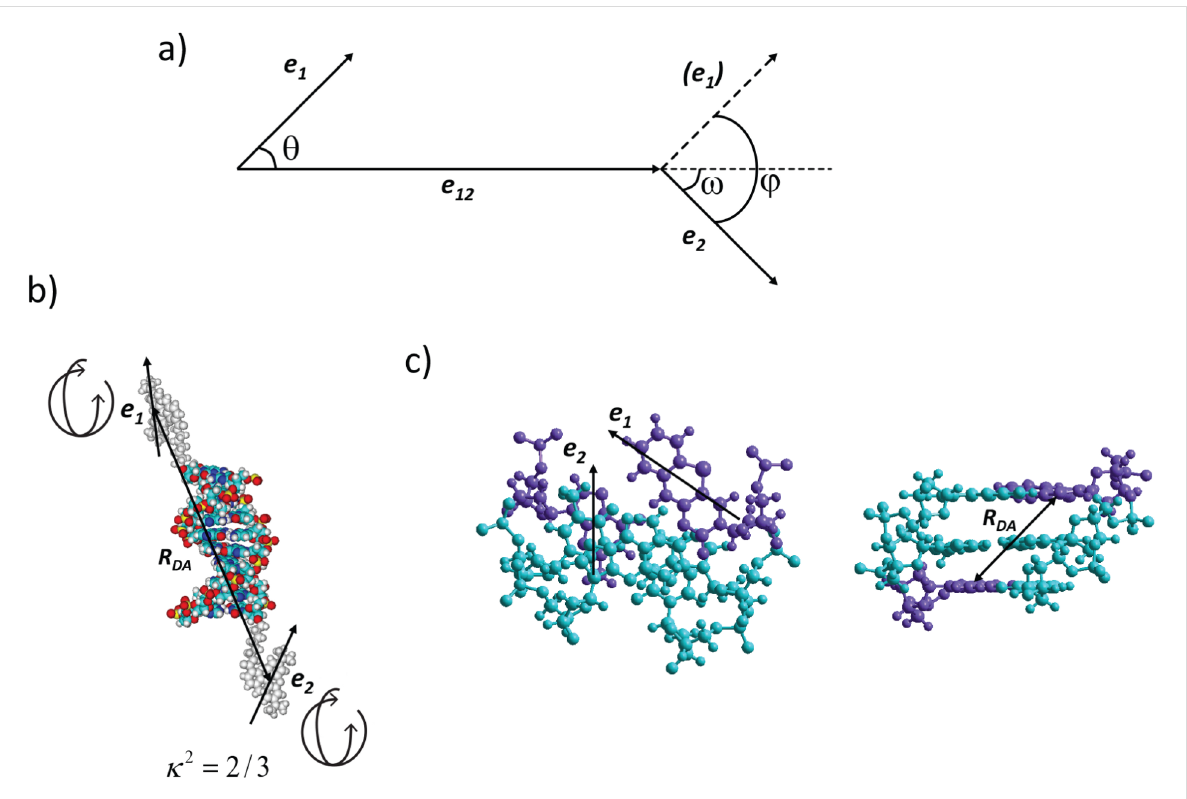
Figure 1: a) Angles and unit vectors used to define the relative orientations of the donor and acceptor transition dipole moments ( e 1 , e 2 ) and the separating vector ( e 12 ). b) Illustration of the external fluorophores covalently attached to a DNA and their transition dipole moments ( e 1 , e 2 ) with free rotation relative to the DNA, i.e., isotropic orientation, κ 2 = 2/3. R DA is the separation between donor and acceptor. c) DNA top-view (left) and side- view (right) illustrating the typical situation for the virtually static transition dipole moments ( e 1 , e 2 ) of fluorescent base analogues in base–base FRET and the distance separating them ( R DA